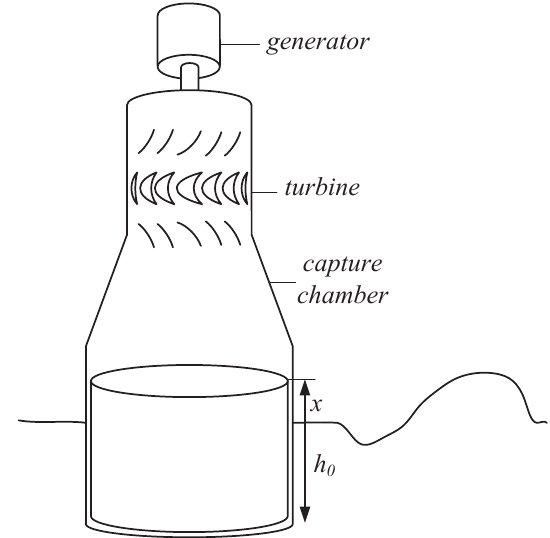
Figure 1. A model of the oscillating water column